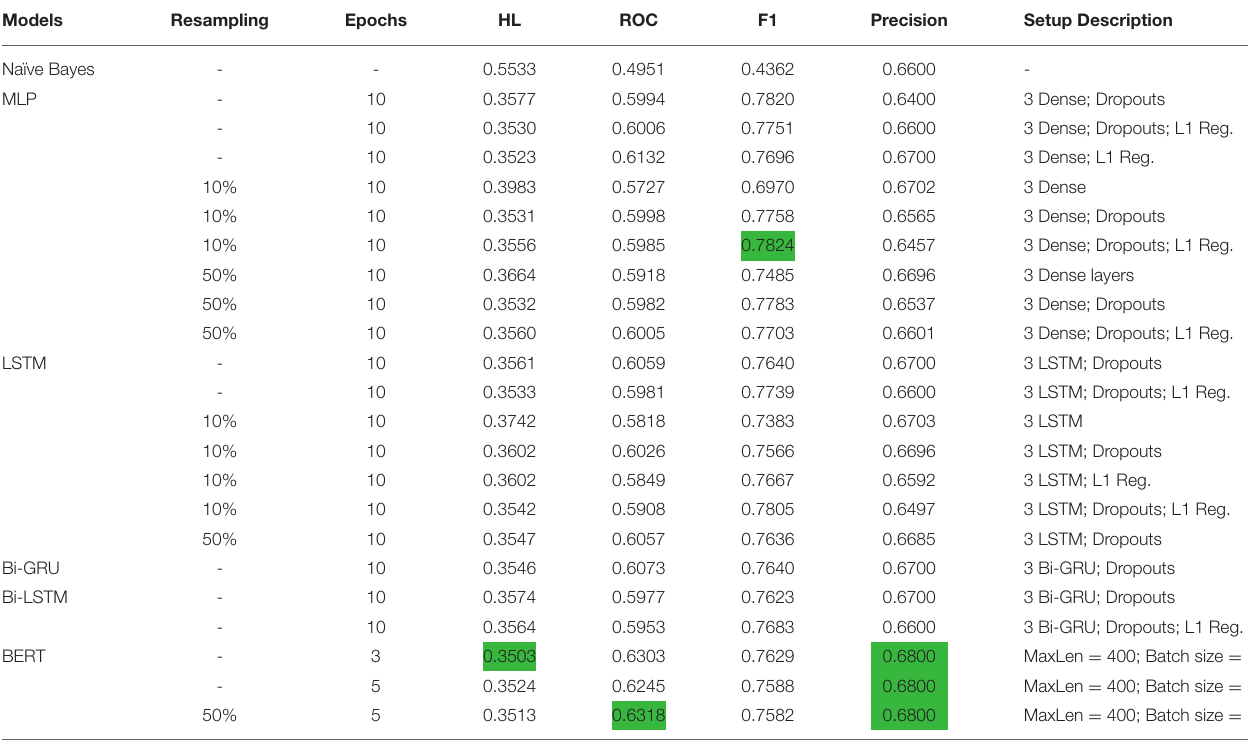
TABLE 3 | Detailed results from different setups that used multilabel classification where the deep learning models attempted to learn patterns between the three offense types (best results are highlighted in green).